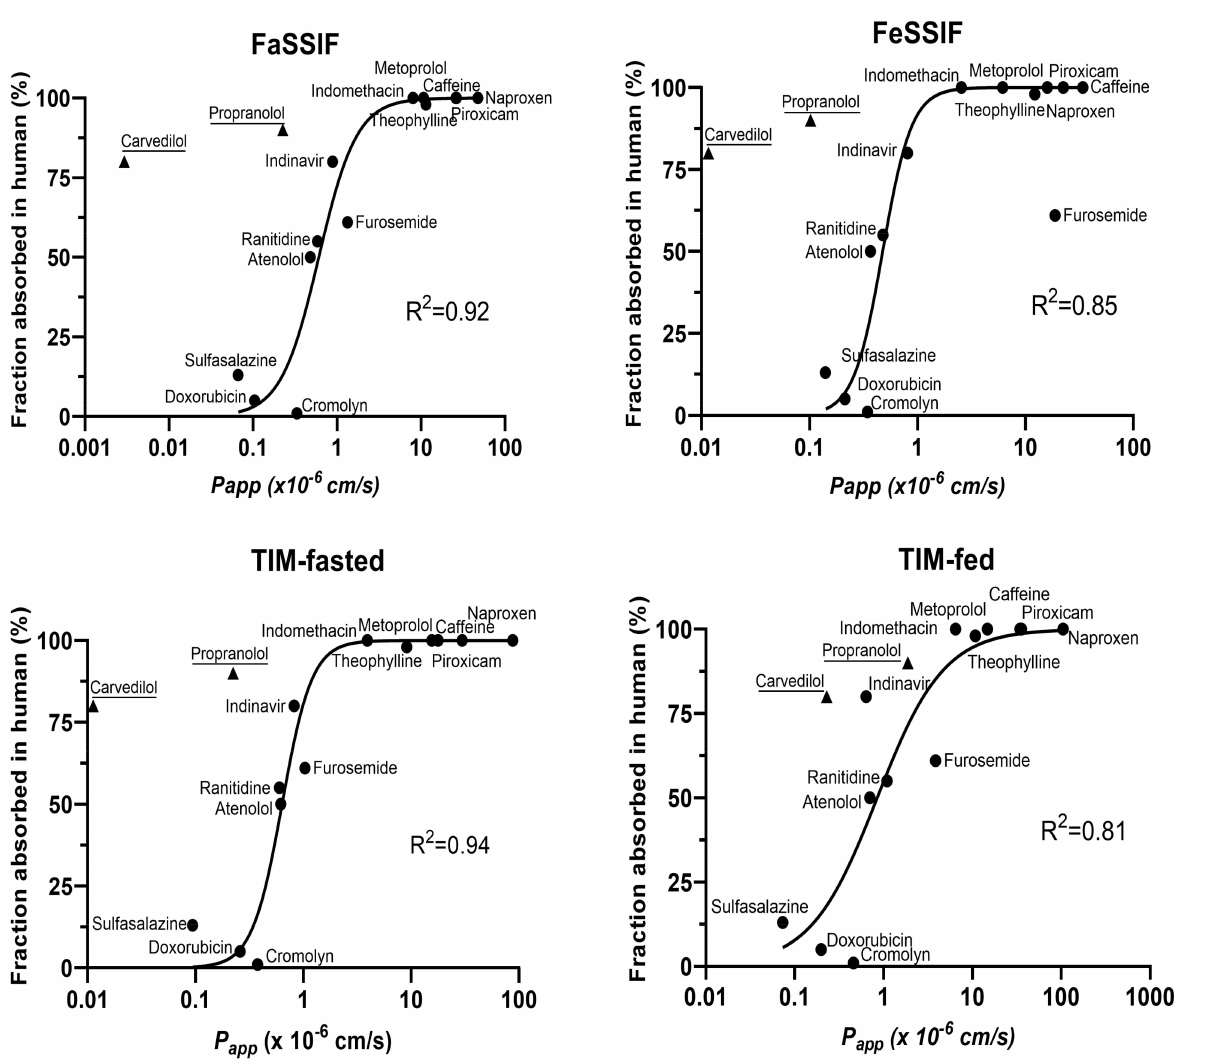
Figure 4. Correlation between Caco-2 P app measured in different biorelevant media human f a . The sigmoidal correlations with human f a were performed using Caco-2 P app (propranolol and carvedilol excluded) measured with FaSSIF, FeSSIF, TIM-fasted and